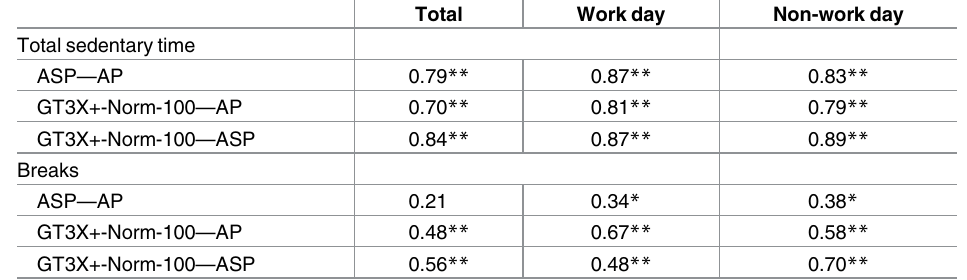
Table 3. Pearson’s correlation coefficients to examine overall magnitude correlation of the sedentary time and breaks among monitors.